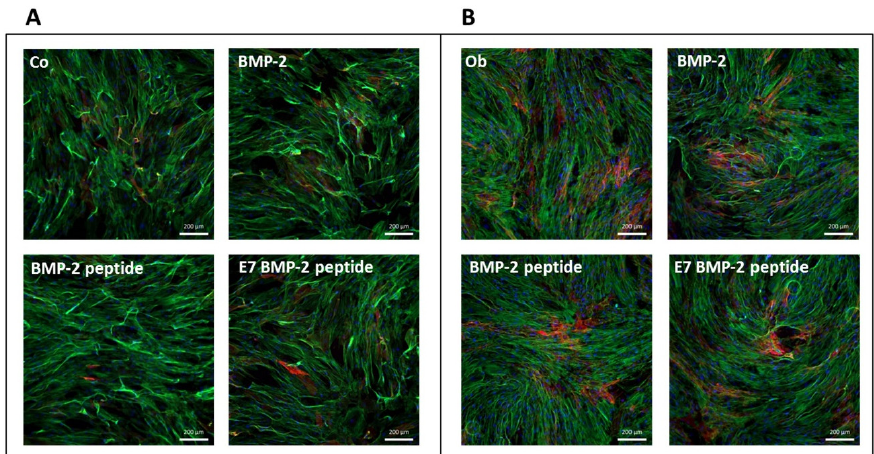
Figure 5. Representative pictures from three independent experiments for the detection of alkaline phosphatase (AP) expression by JPCs (red) with a DAPI (nuclei staining - blue) and phalloidin (cytoplasmic staining - green) staining. Cells were cultivated in 2D culture plates in the absence or presence of recombinant BMP-2 or BMP-2 mimicry peptides with or without E7-Tag under normal ( A ) or osteogenic conditions ( B ) and alkaline phosphatase activity (red) was detected.